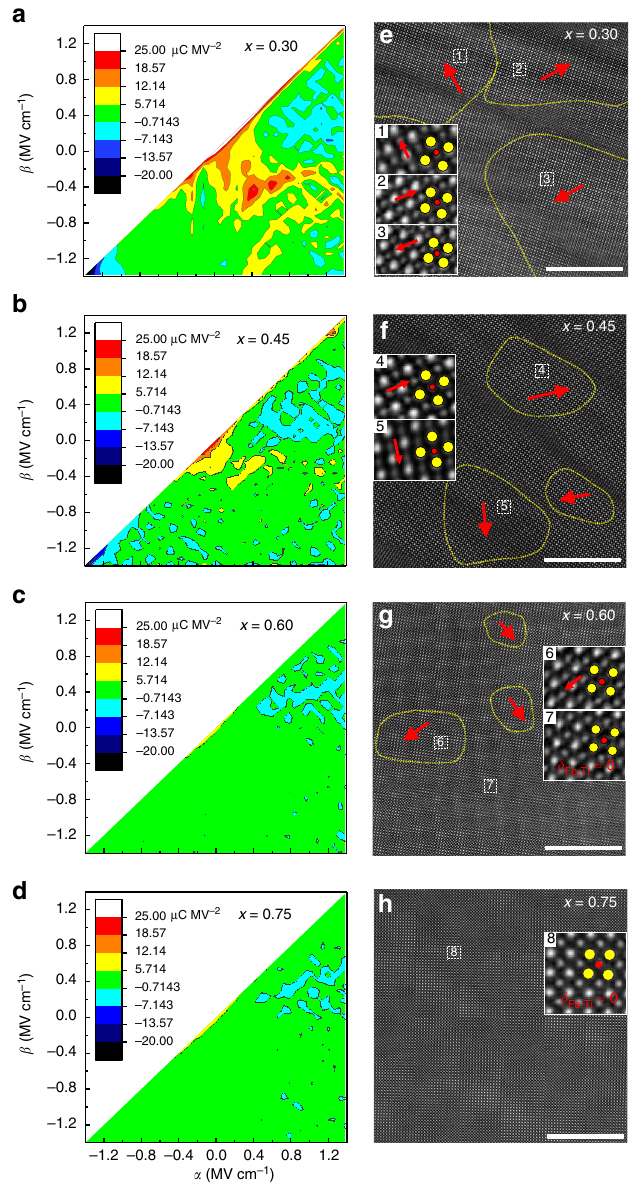
Fig. 4 Evolution of FORC distribution and domain con fi guration. a – d FORC distribution p ( α , β ) and e – h HAADF-STEM images of the atomic-scale ferroelectric domain structure of the BFSTO fi lms (scale bars: 10 nm). The yellow dashed lines in e – h mark the domains with spontaneous polarization and the red arrows denote the Fe/Ti ion displacement ( δ Fe/Ti ) directions. The insets of e – h are magni fi ed images of selected areas to show the δ Fe/Ti , where the yellow and red circles denote the Bi/Sr and Fe/Ti ion columns,